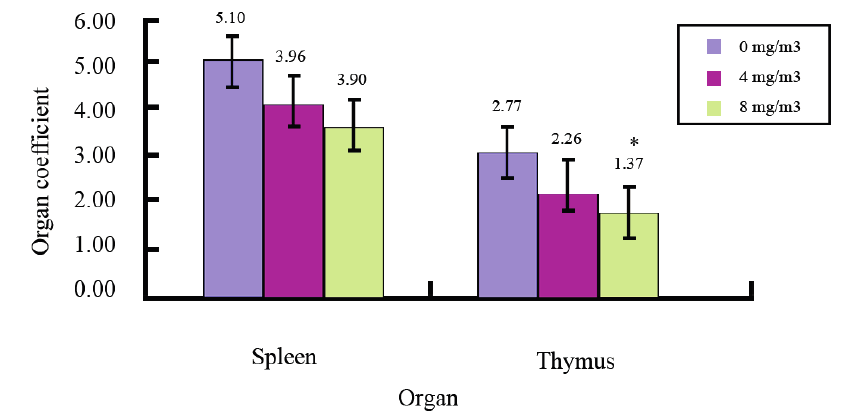
Figure 1. Immune organ coefficients of formaldehyde (FA) exposed mice compared with control mice. * Significant difference compared with control group ( p < 0.05).